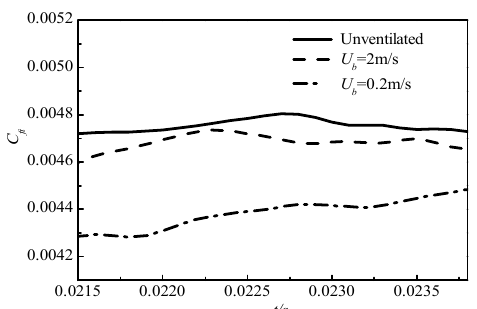
Figure 9. Drag coefficient of the flat plate at both injection speeds. The data shown were extracted from the plate below 20 mm downstream from the obstacle line. Table 2. Drag reduction at both injection speeds.